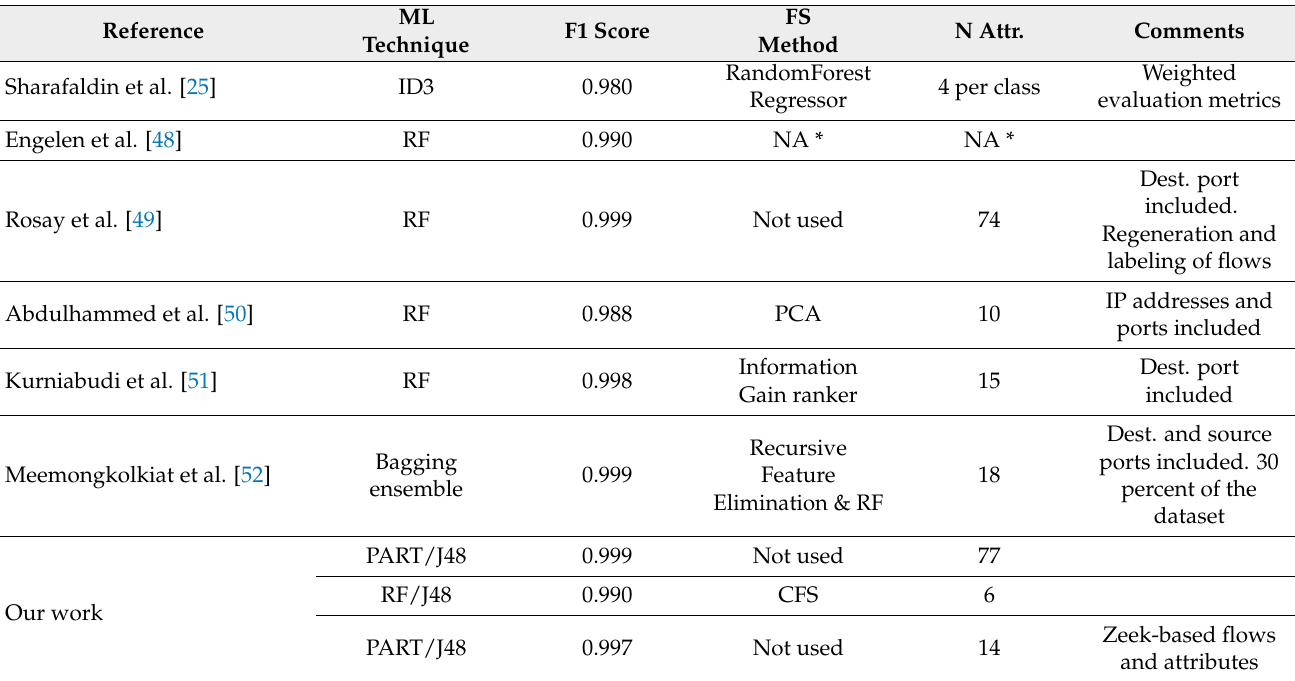
Table 22. Performance results of related works in the CICIDS2017